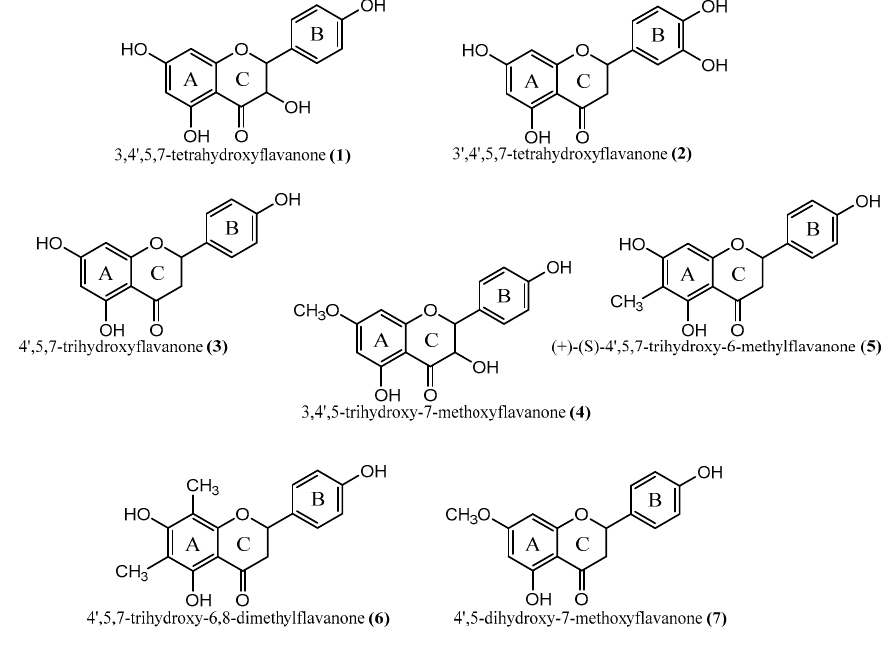
Figure 1. Structures of seven flavonoids isolated from the kino of Corymbia torelliana .